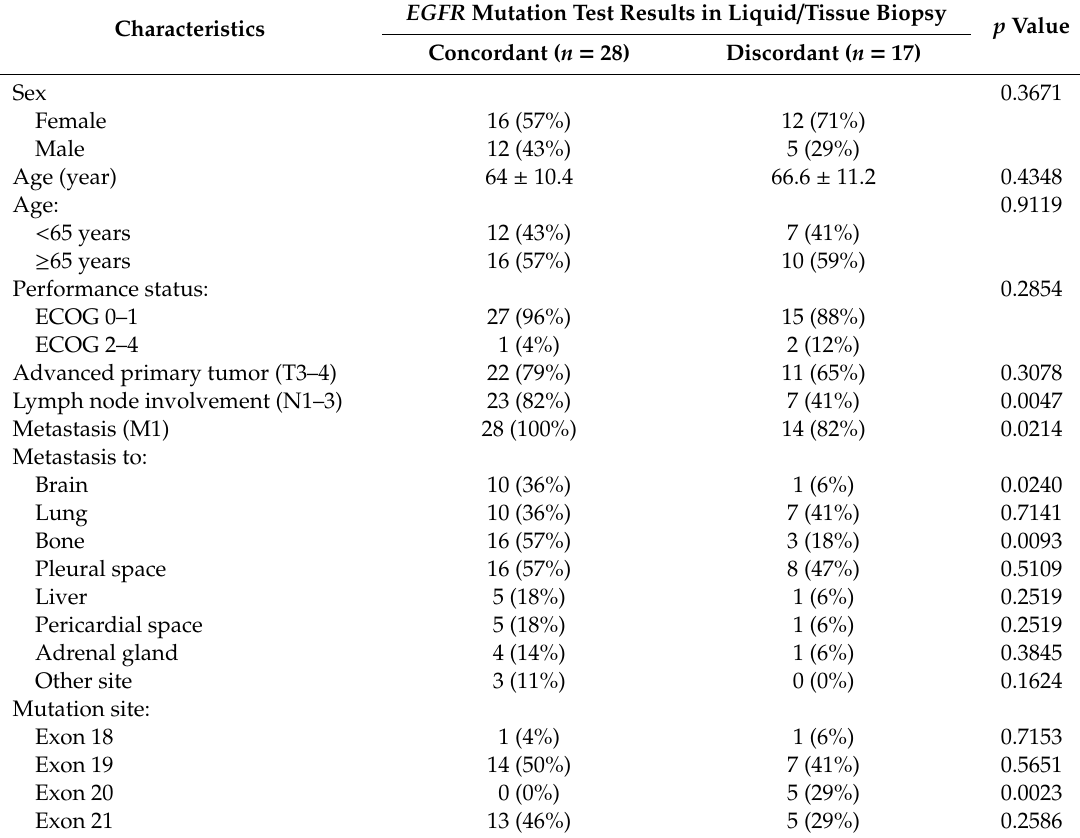
Table A1. Baseline characteristics of the study population, stage III or IV lung adenocarcinoma patients having EGFR mutations detected in the tissue samples (only patients using Qiagen ® EGFR RGQ PCR kit for their tissue samples). EGFR Mutation Test Results in Liquid / Tissue Characteristics